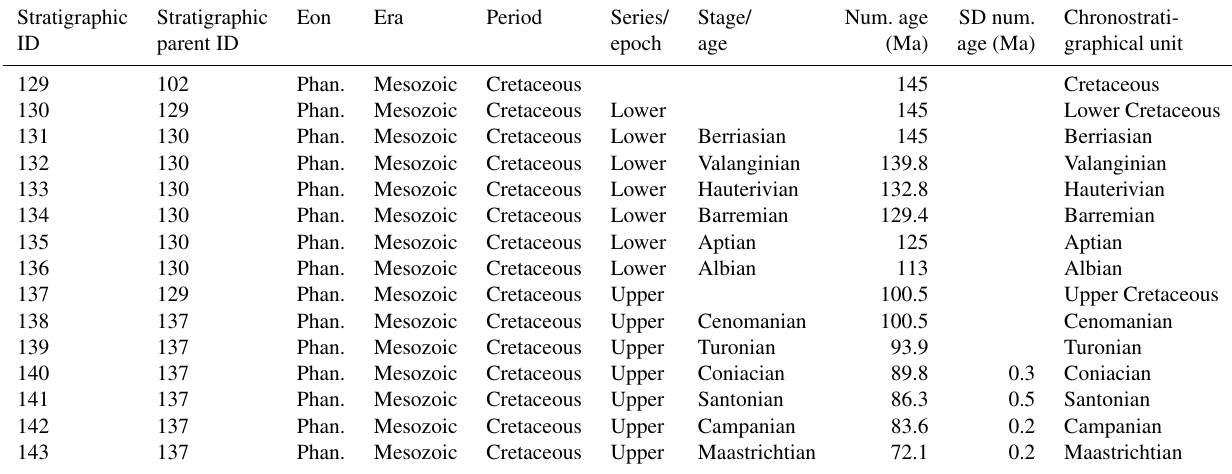
Table 2. Excerpt from the stratigraphic classification table used for P 3 (based on Cohen et al., 2013, updated). Different ranks and their interconnection by stratigraphic ID and stratigraphic parental ID are indicated. Num.: numerical; SD: standard deviation; Phan.: Phanerozoic.